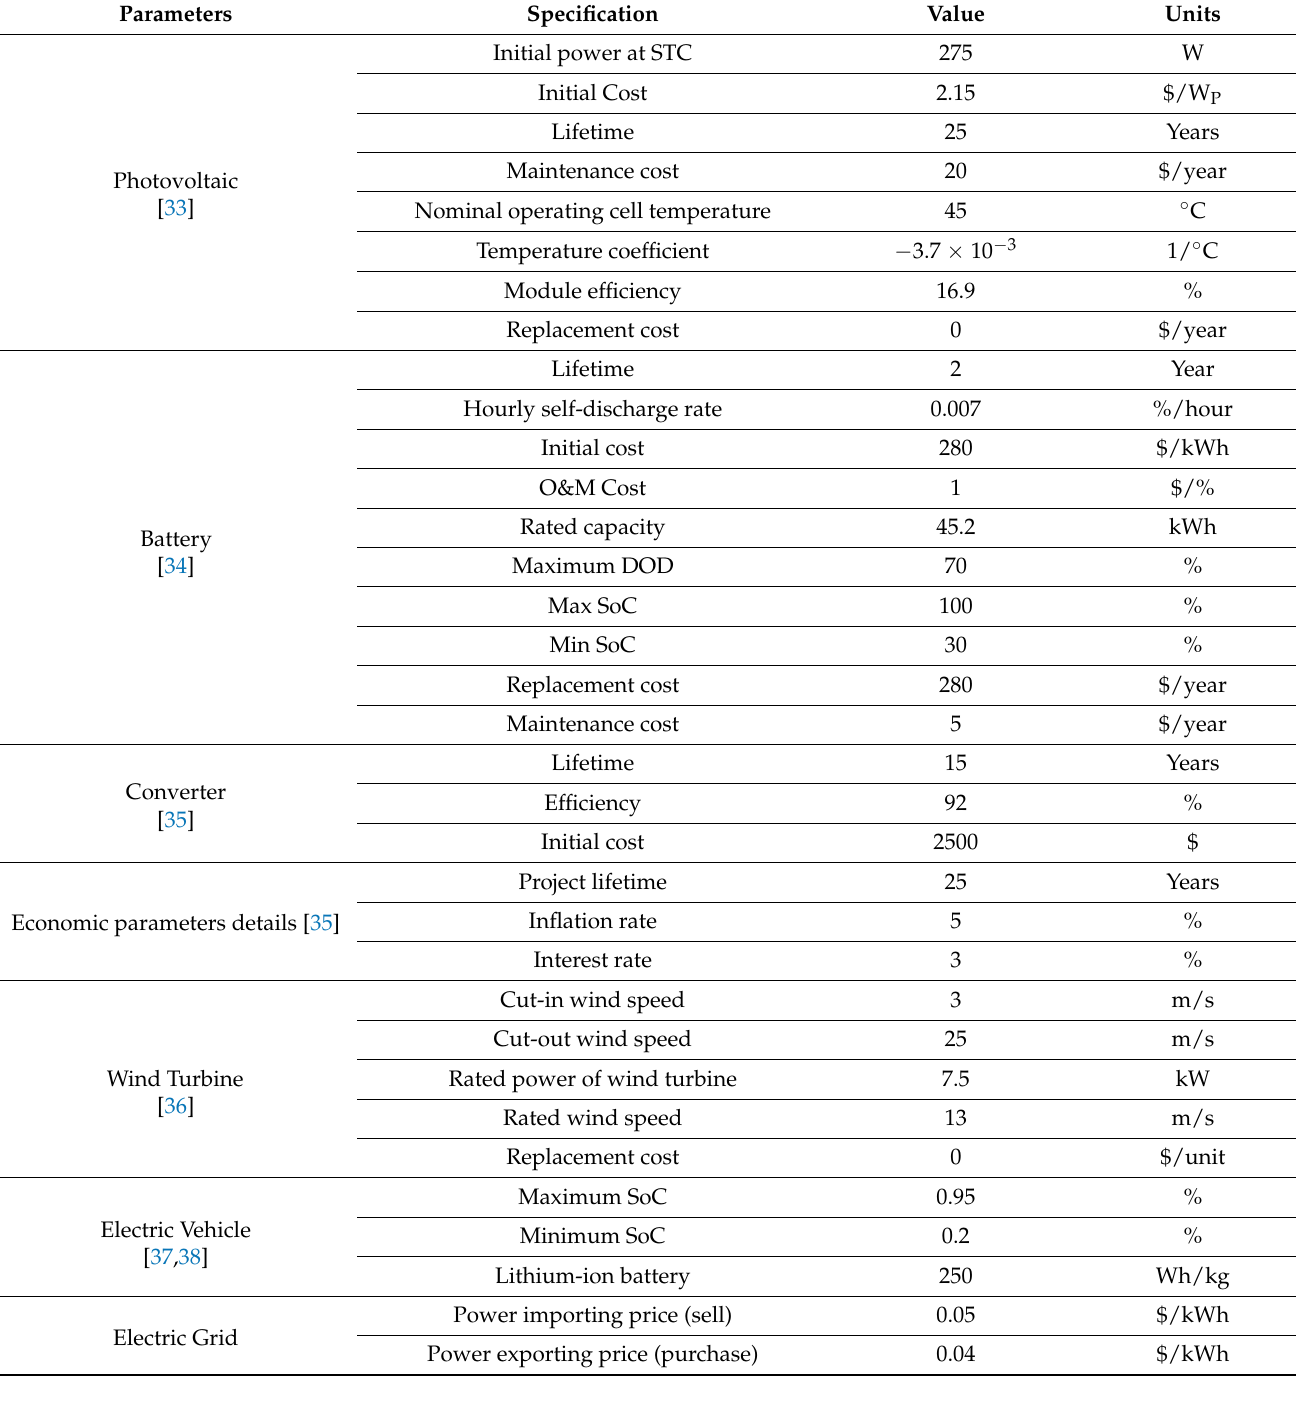
Table 1. Input components and economic parameters